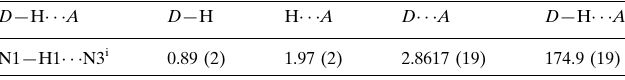
Hydrogen-bond geometry (A˚ , (cid:2)